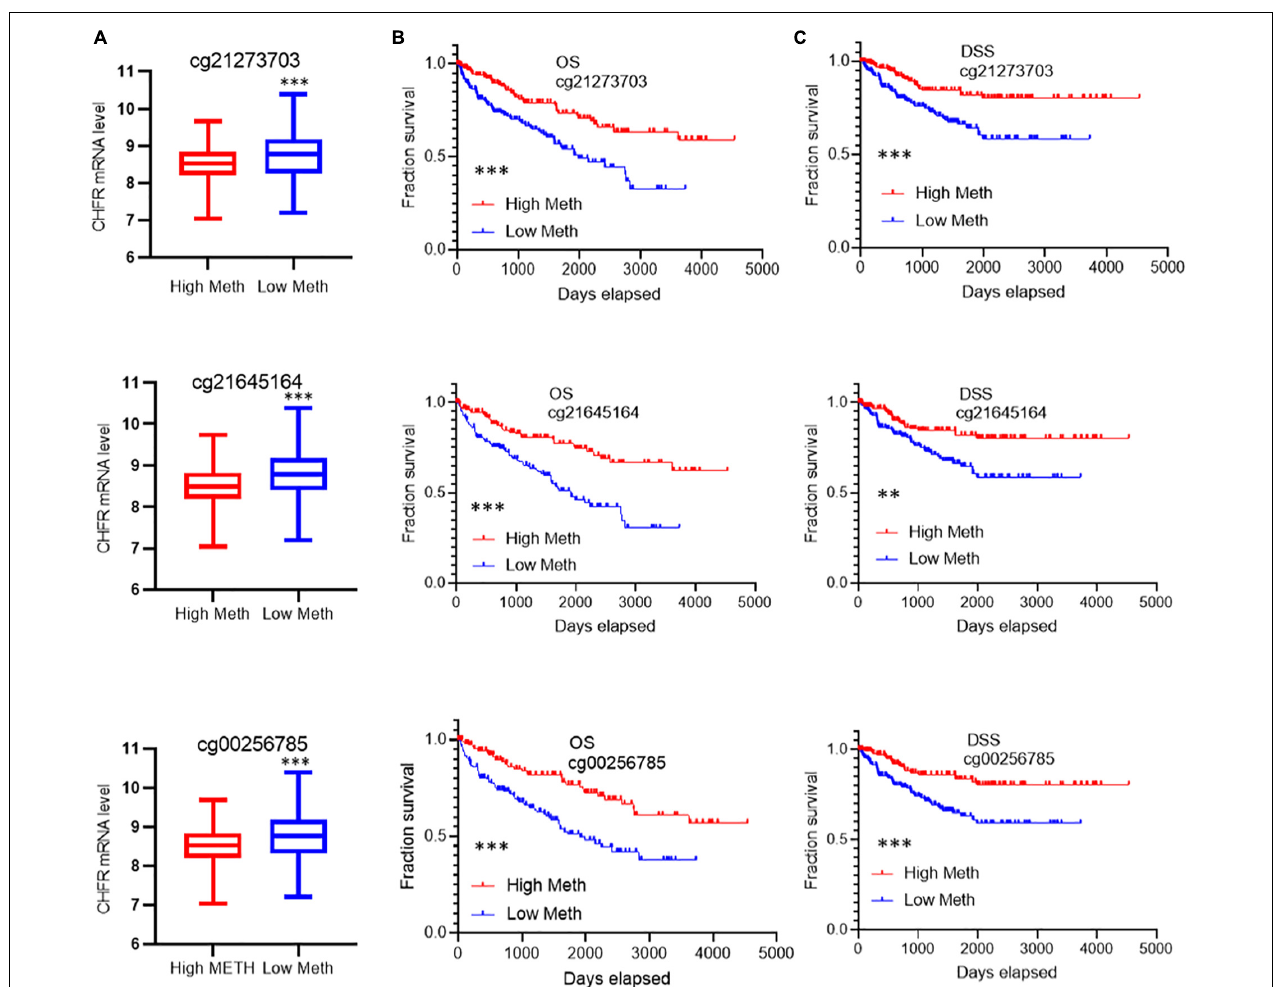
FIGURE 5 | Correlation of the top 3 methylation sites with prognosis and CHFR expression: (A) Low levels of methylation at all three modification sites are associated with high gene expression (B,C) and associated with poor prognosis including overall survival and disease-specific survival * p < 0.05, ** p < 0.01, *** p <